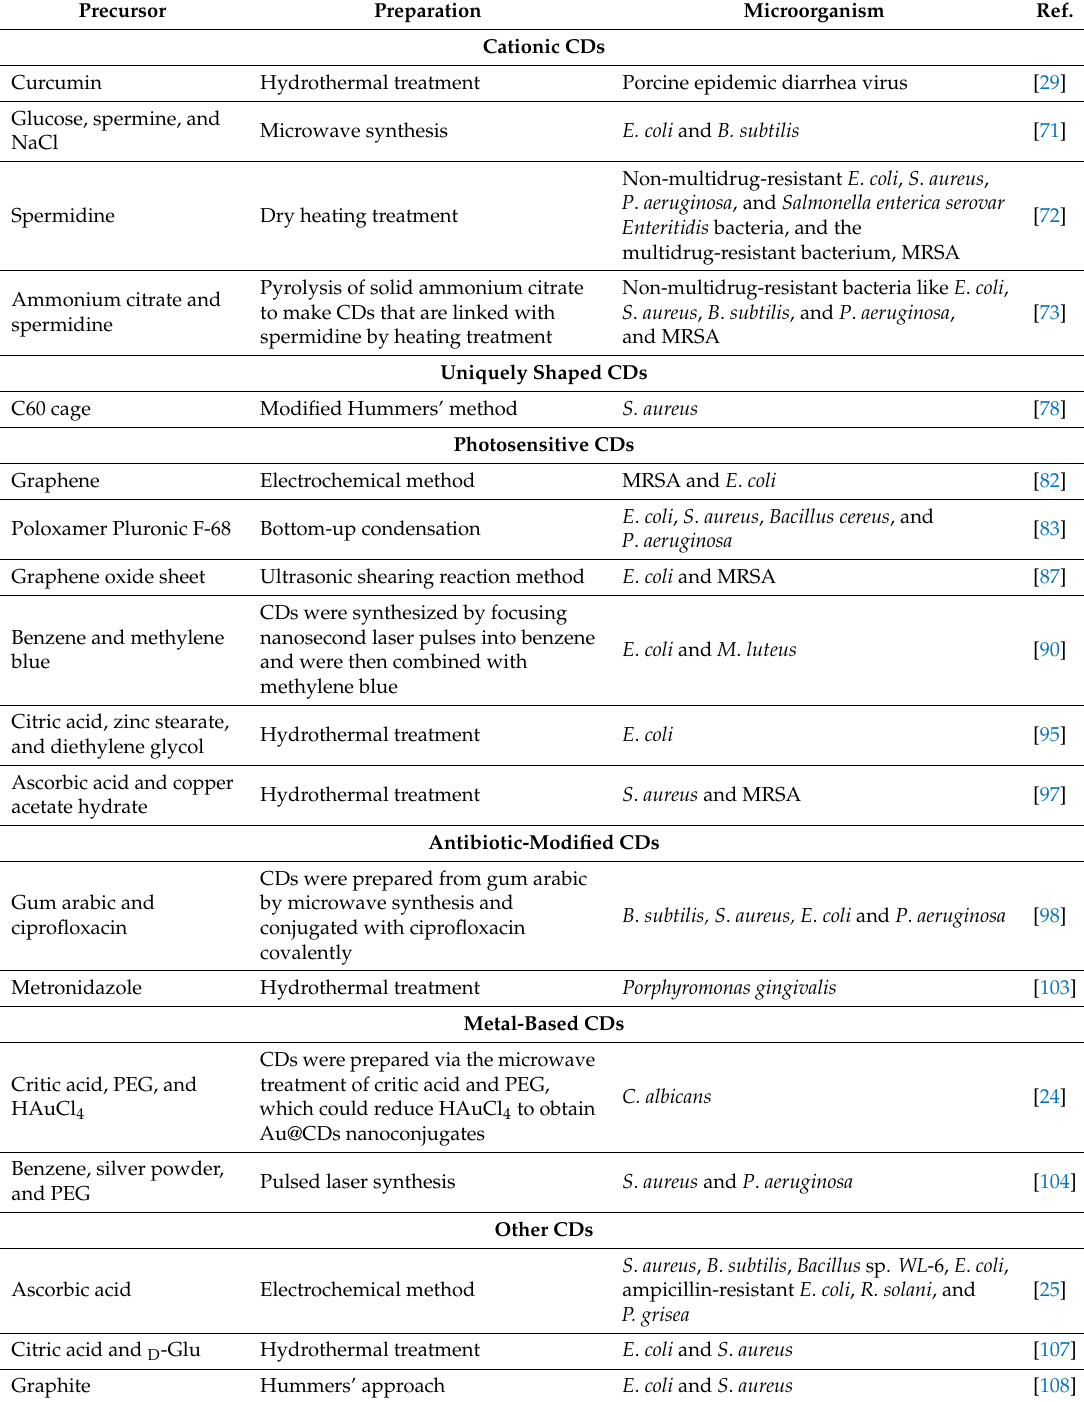
Table 1. Representative CDs for killing